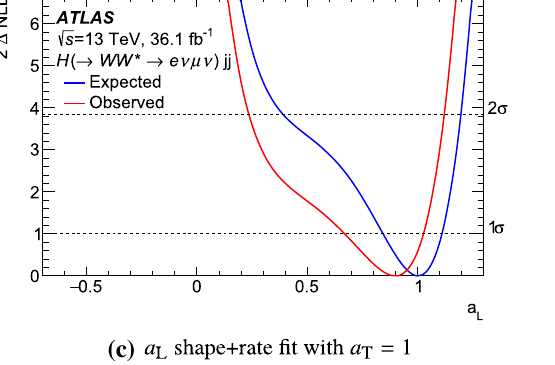
Fig. 8 Likelihood scans over the transversely ( a , b ) and longitudinally ( c ) polarised couplings. Fits using shape-only ( a ) and shape+rate ( b , c ) information are shown. All relevant experimental and modelling systematic uncertainties are considered in the fits Table 9 Best-fit values and their uncertainties as obtained from the for a L and a T are shown. Results of fits to one parameter with the other shape-only and shape-plus-rate likelihood fits to the Asimov dataset one fixed or profiled are presented and to ATLAS data. Results of both the shape-only and shape+rate fits